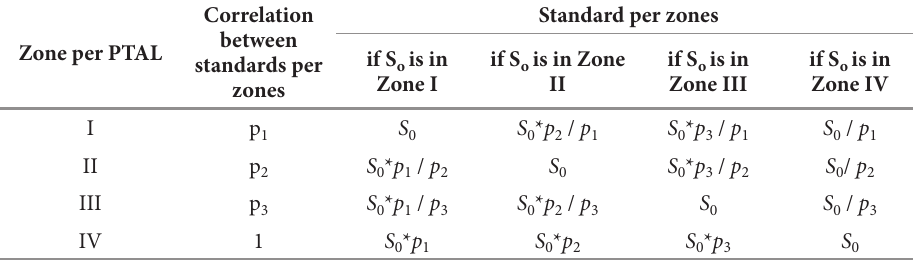
Table 3. Calculation of standards per zones Zone per PTAL